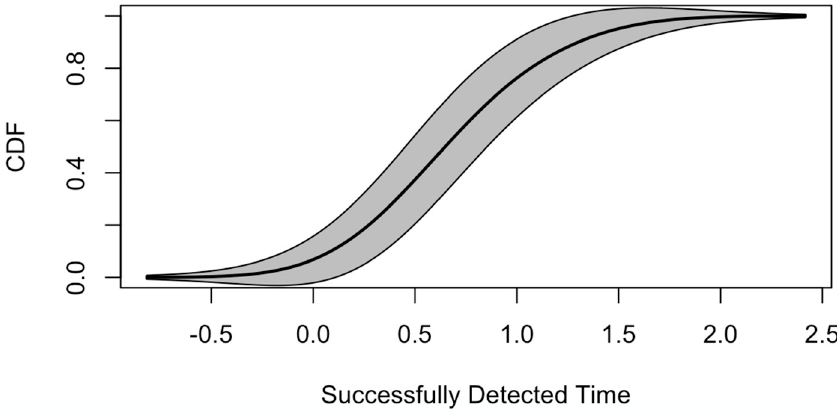
Figure 16. Real-time turning detected time (overall)